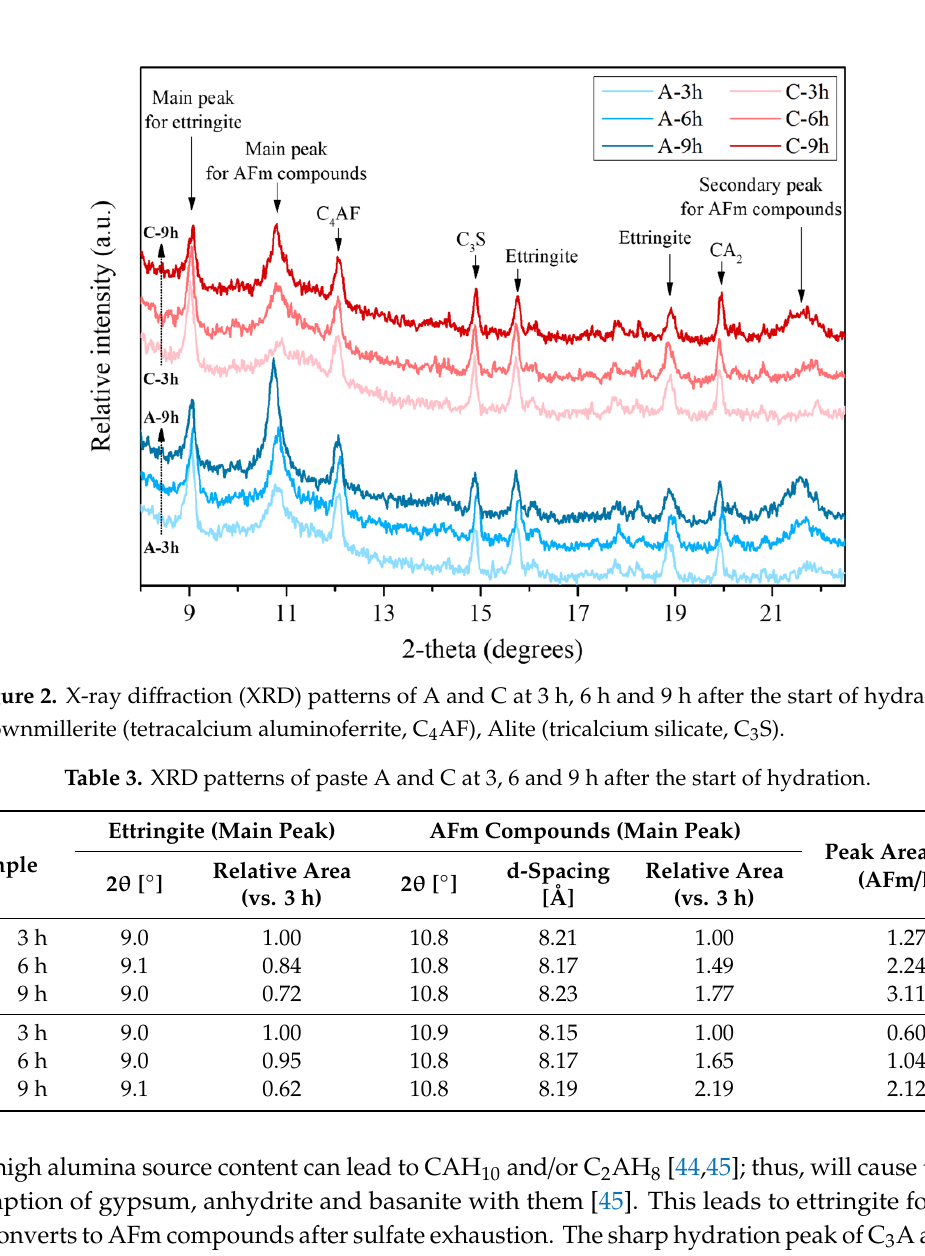
Table 3. XRD patterns of paste A and C at 3, 6 and 9 h after the start of hydration. Ettringite (Main Peak) AFm Compounds (Main Peak) Sample